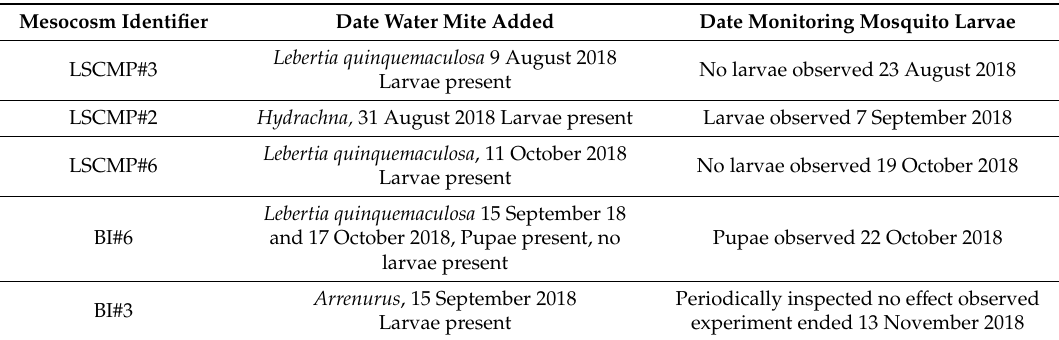
Table 1. Water mite impact on numbers of mosquito larvae in field-deployed